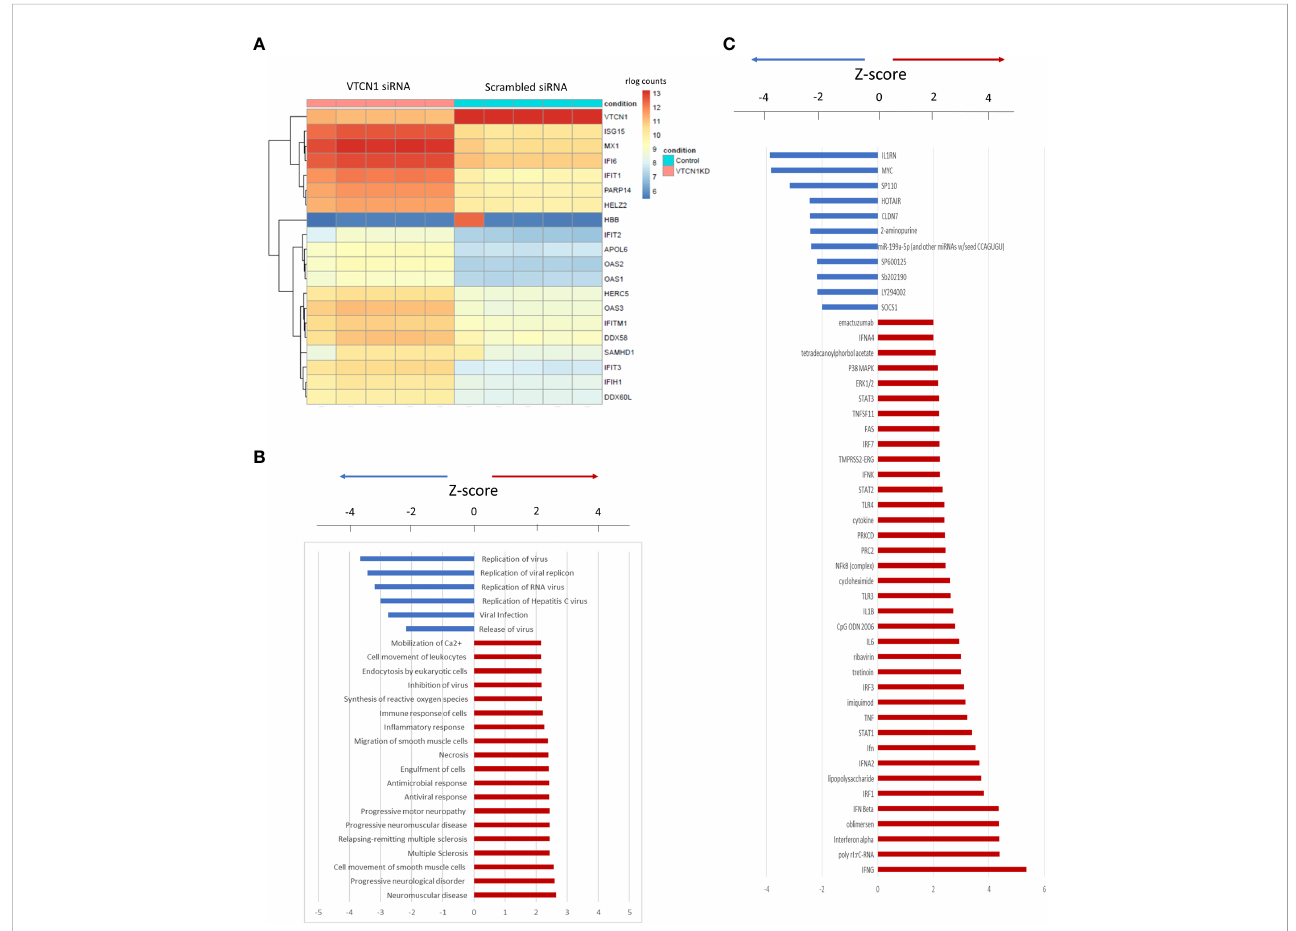
FIGURE 3 (A) Heatmap of the top 20 differentially expressed genes 24 h after VTCN1 KD on d3 of BAP treatment. rlog count (regularized logarithm transformed count) re fl ects gene expression normalized to the sequencing depth of each sample. (B) Affected functional categories 24 h after transfection. (C) Gene activation 24 h after